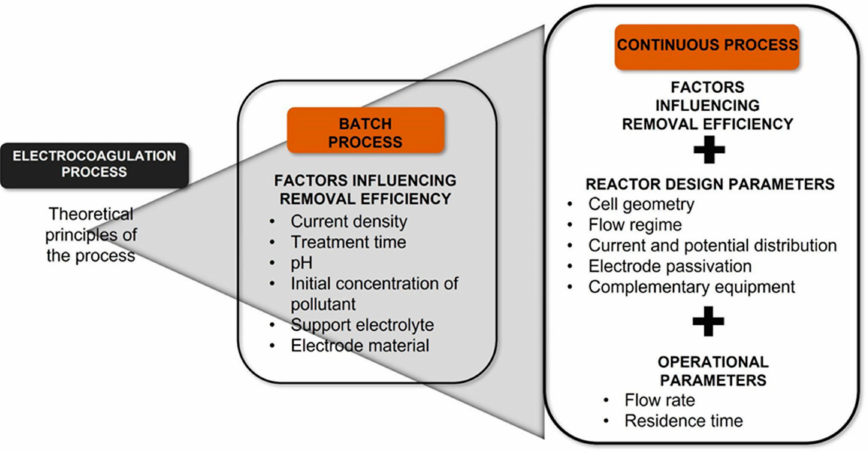
Figure 1. Steps of design continuous EC